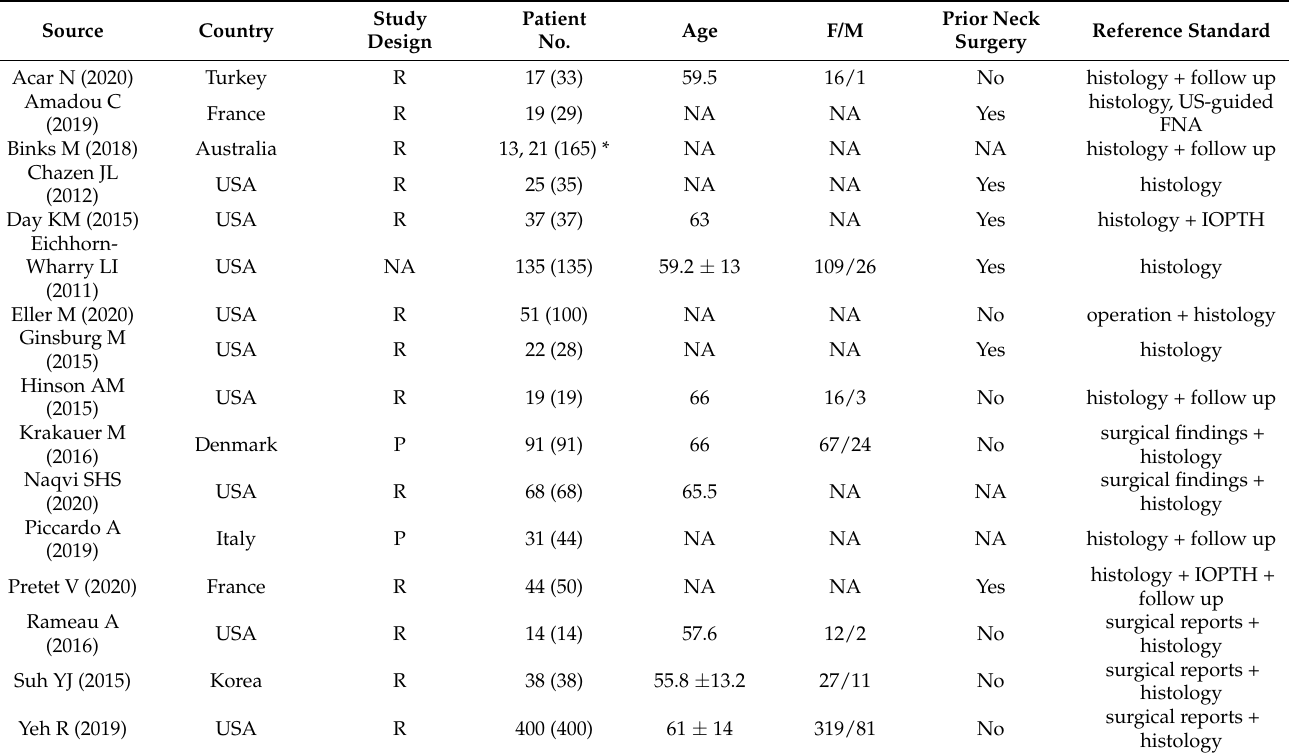
Table 1. Basic information of included study characteristics.